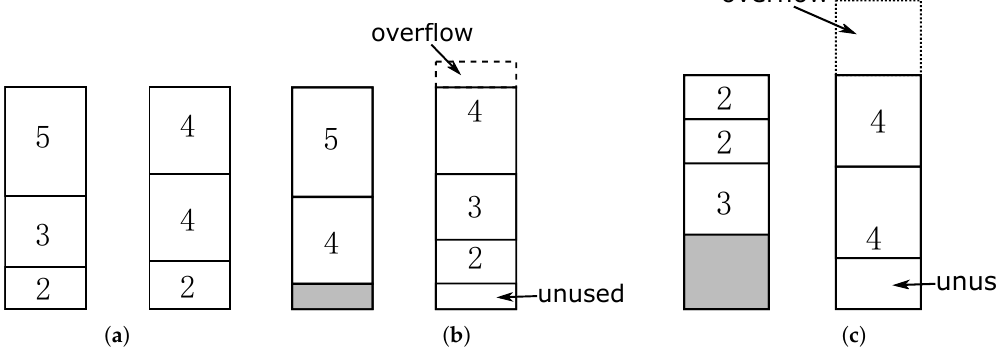
Figure 3. Different transmission orders result in different energy waste. ( a ) Order of 5,3,2,4,4,2; ( b ) Order of 5,4,4,3,2,2; ( c ) Order of